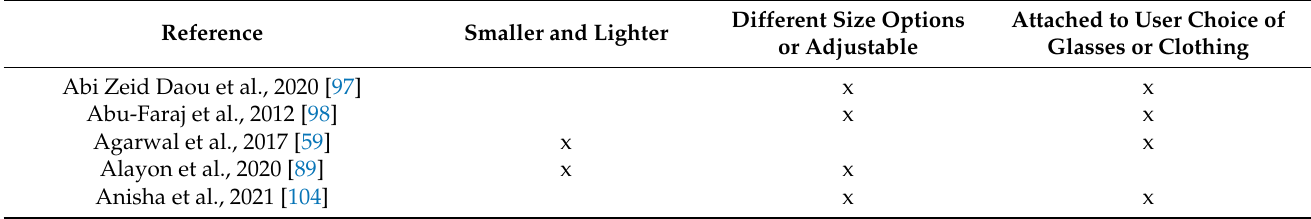
Table 7. Suggested improvements in form and